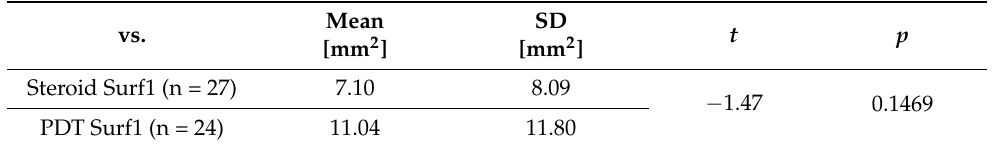
Table 4. Results of unpaired t -Student test to comparison size of surface after treatment (Surf1) between local steroid (Steroid) and photodynamic therapy (PDT) treatment (SD—standard deviation, t —value of t -Student test).